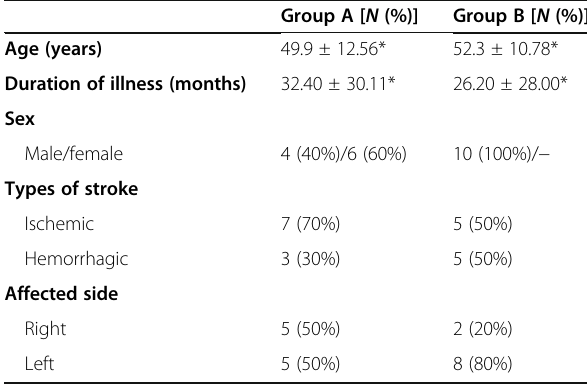
Table 1 Baseline characteristics of all participants allocated in group A and group